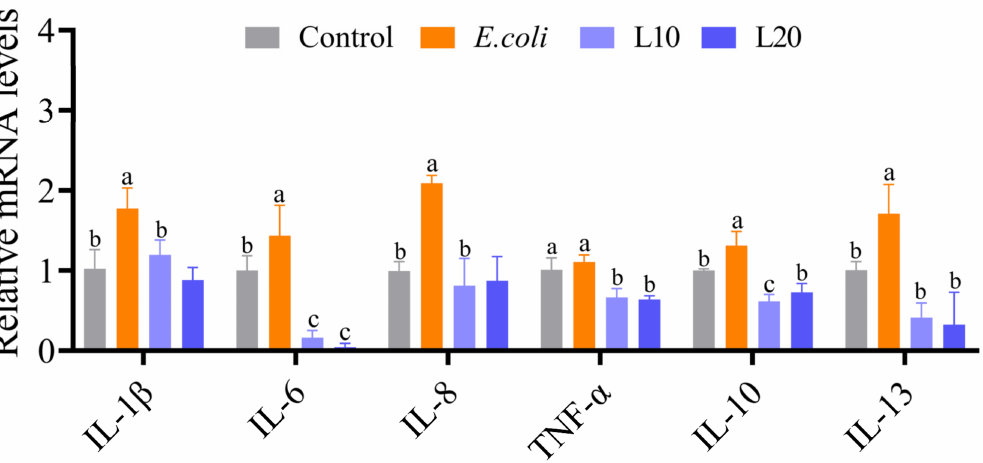
Figure 5. Luteolin treatment significantly improved the expression of E. coli -induced inflammatory cytokines. The effect of luteolin on the mRNA levels of inflammatory genes in each group. The data are expressed as mean ± SD. A statistical difference ( p < 0.05) is shown by different letters.